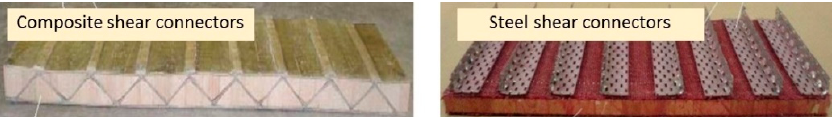
Figure 10. Used connectors by Mastali et al. Adapted from [46–48].